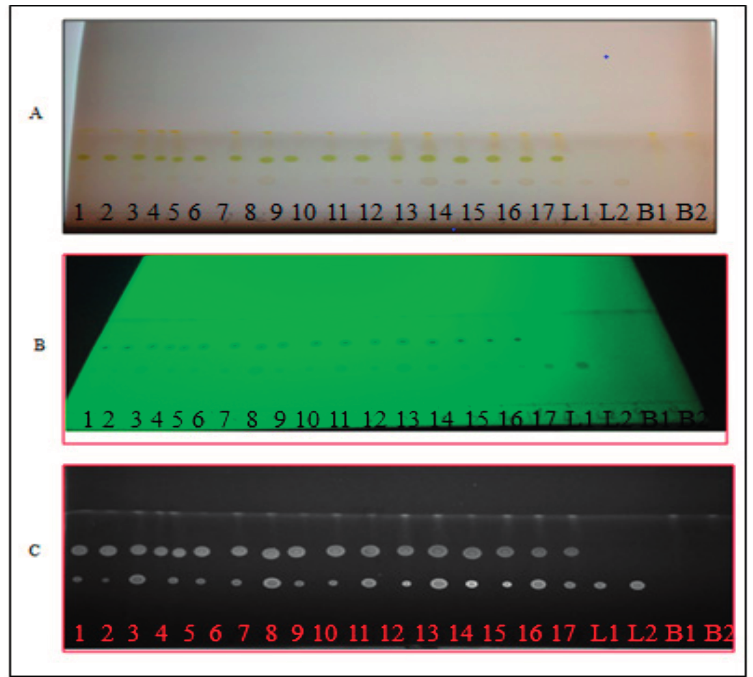
Figure 4. The chromatographic separation of lutein (L) and β -carotene (B): ( A ) real visible light image; ( B ) UV image at 254 nm; and ( C ) grey scale image by Quantity One software. Spots: 1 to 17 for spinach extracts; L1 and L2 for lutein controls; and B1 and B2 for β -carotene